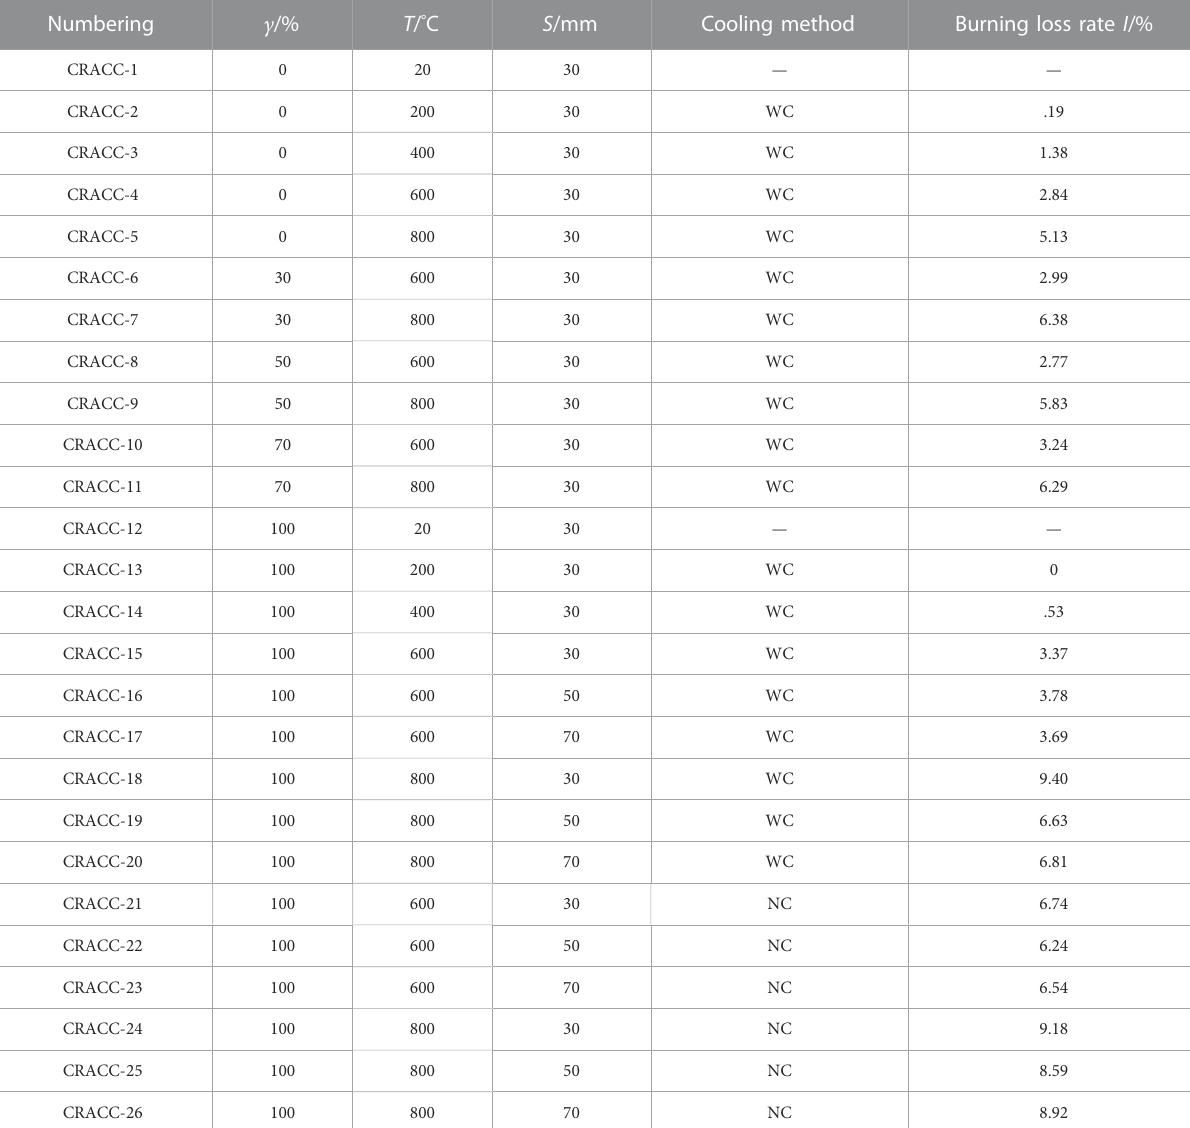
TABLE 1 Design parameters and burning loss rate.